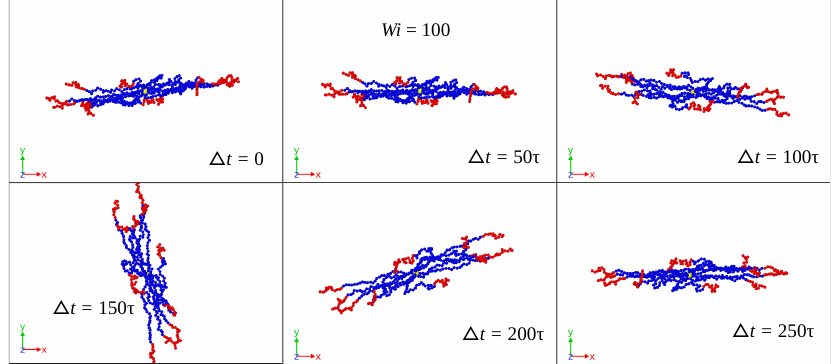
Figure 3. Time evolution of the (fixed) reference configuration in Eckart’s frame as seen in the laboratory frame for Case 1 and Wi = 100.